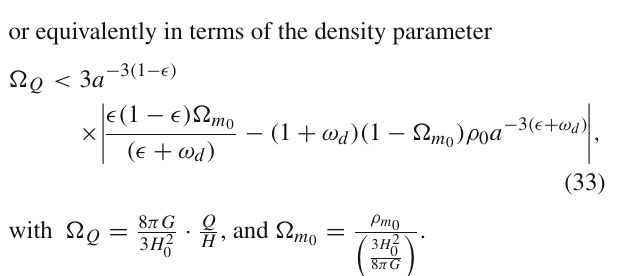
Fig. 4 The shaded portion is the admissible domain for (cid:6) Q in the negative region for ω d = − 0 . 45, (cid:6) m